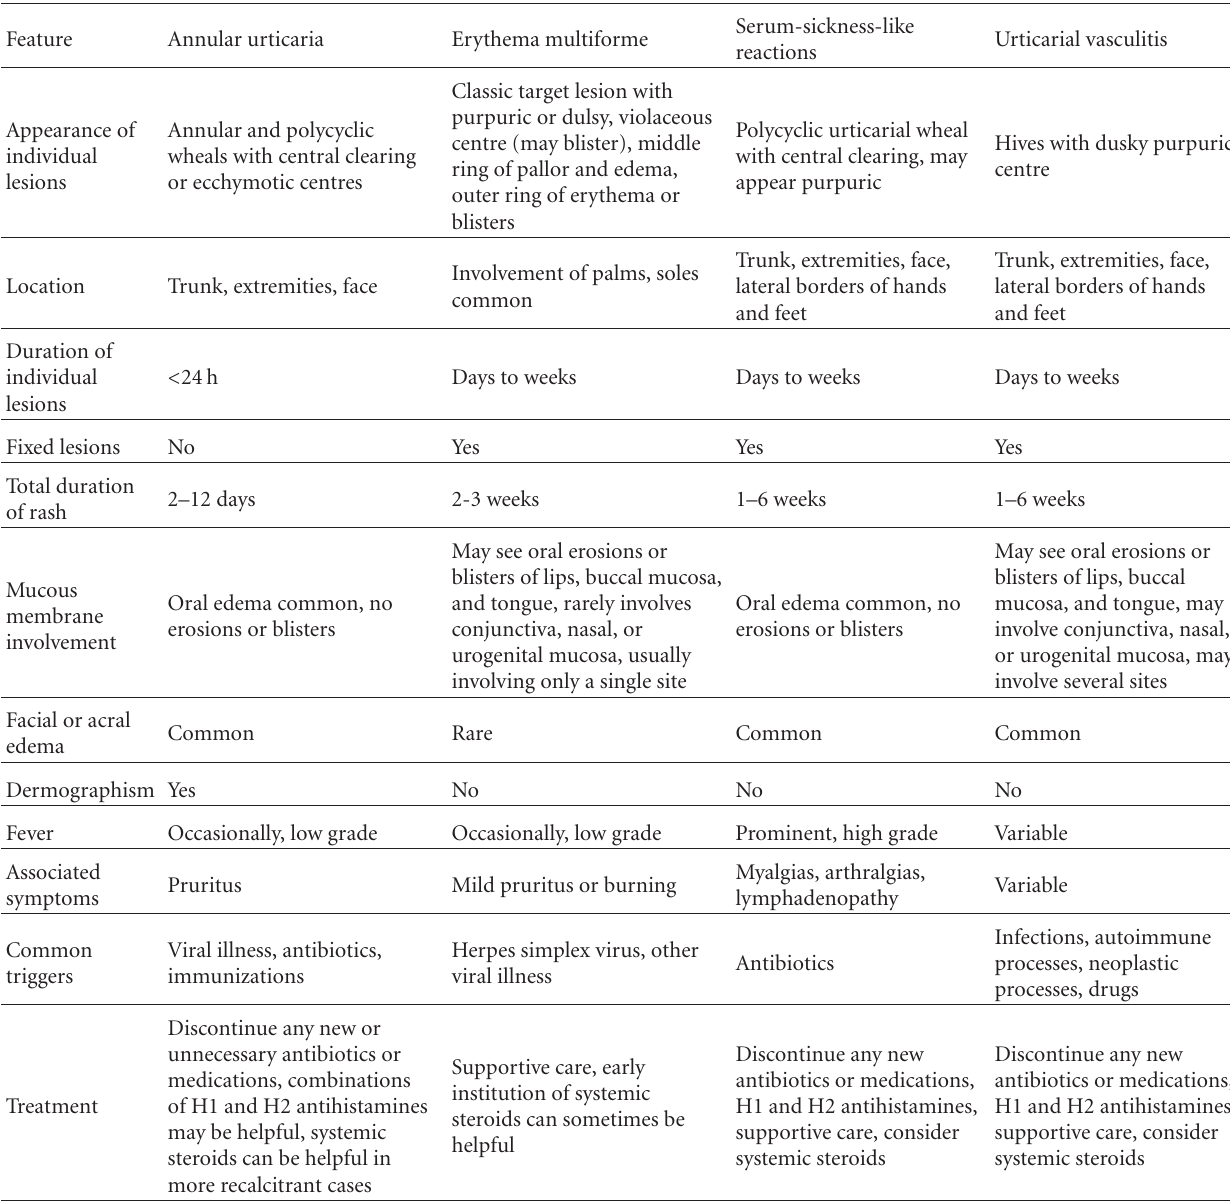
Table 1: Distinguishing features of annular urticaria, erythema multiforme, and serum-sickness-like